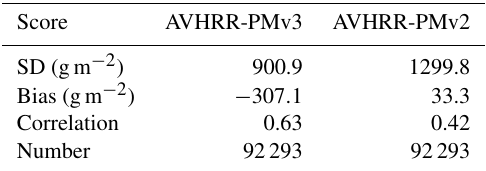
Table 6. Ice water path (IWP) validation results for Cloud_cci AVHRR-PMv3 when compared with DARDAR for January to July 2008. Validation results for AVHRR-PMv2 for the same time period are also reported. Validation measures are standard deviation (SD) of the error, the mean error (bias) and correlation. In addition the number of collocated pixels is given.